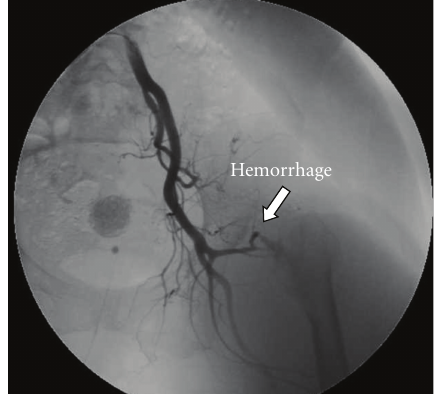
Figure 3: Angiography.